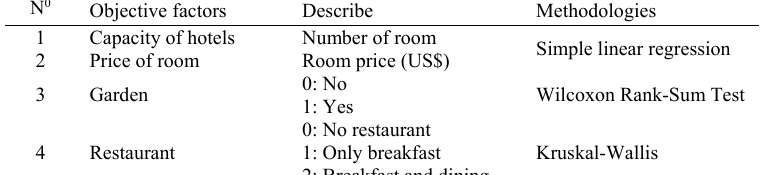
Table 3: Influencing factors of solid waste generation rate of the hotel industry and statistical testing methods N 0